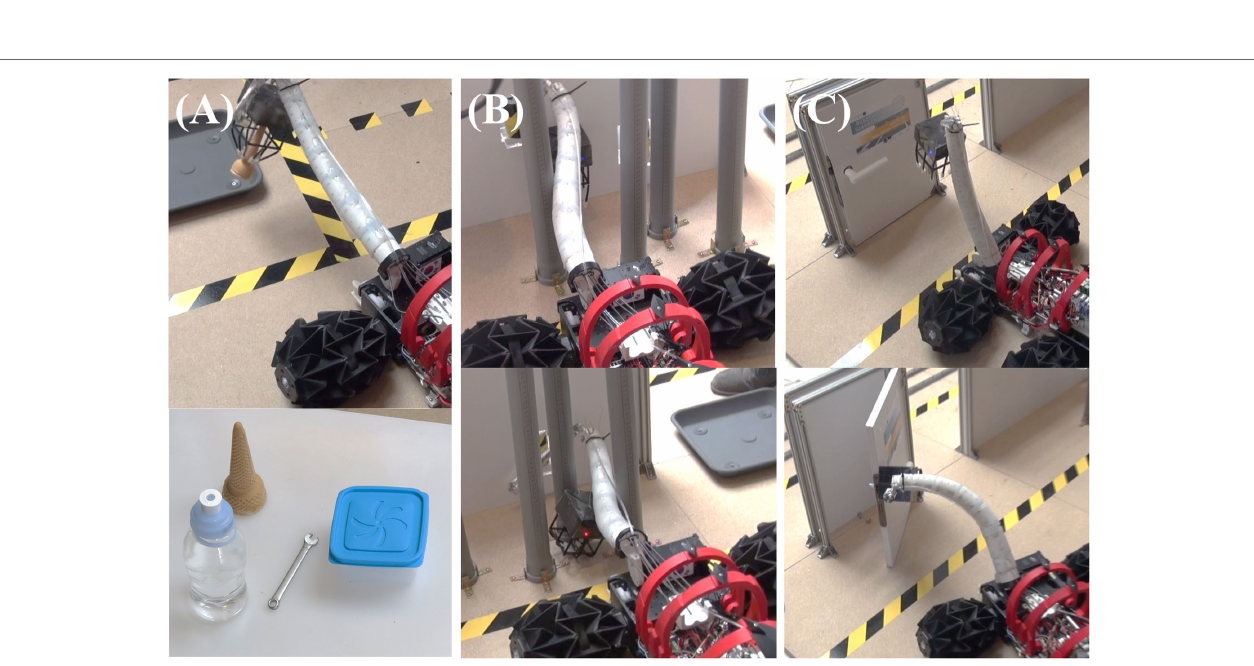
FigUre 12 | Performance during the three manipulation scenario tasks . (a) Object pick and place task: SNUMAX picked up and placed all four objects with its PVSM and adaptive caging gripper. (B) Arm-positioning task: SNUMAX’s PVSM reached all three target positions. (c) Door opening task: Lifting the PVSM while pulling the door allowed SNUMAX to manipulate the door knob and open the